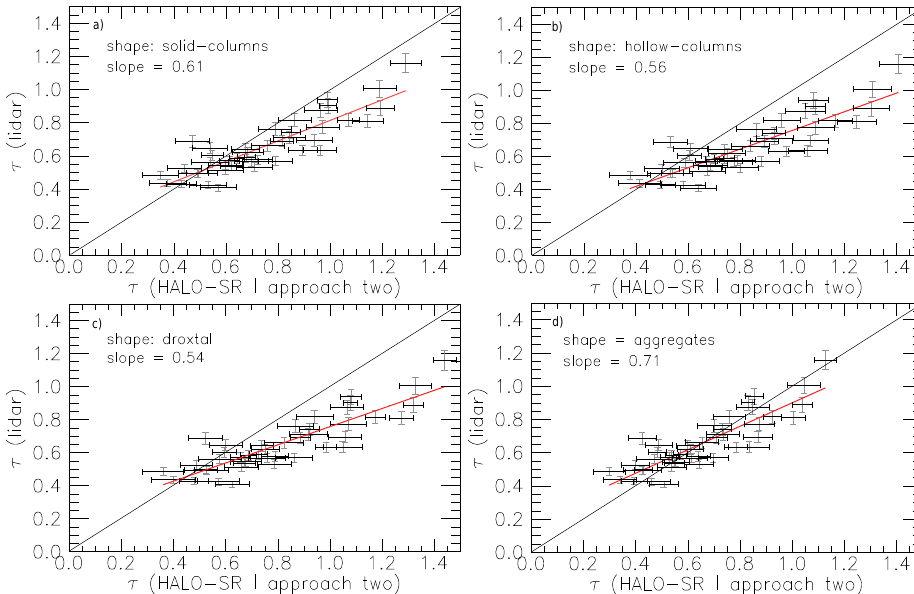
Fig. 17. Comparison of τ retrieved by the HSRL and HALO-SR based surface albedo approach two for different ice crystal shapes. Droxtals (c) show the biggest deviation, hollow (b) and solid (a) columns slighty improve the slope. The best correlation is achieved for aggregates (d). The influence increases with increasing τ . For values below 0.5 a systematic feature, leading to an underestimation is beyond the shape influence.